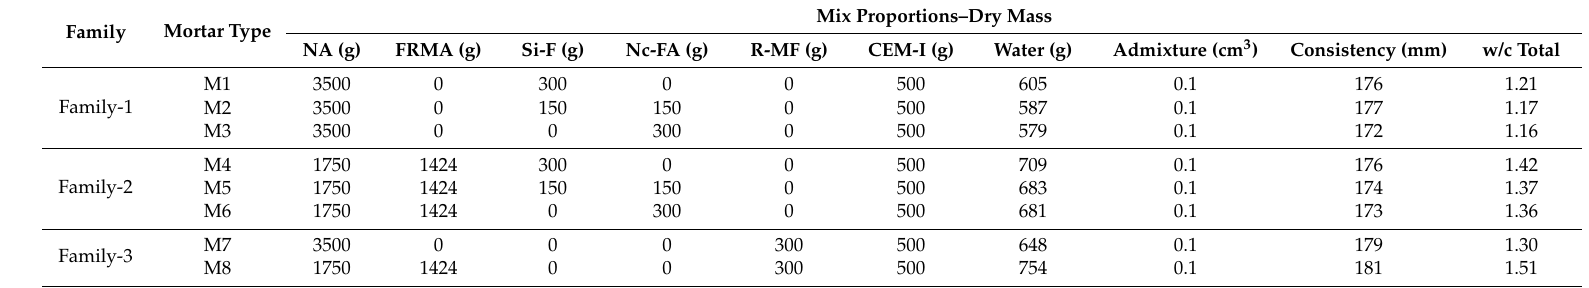
Table 7. Mortars’